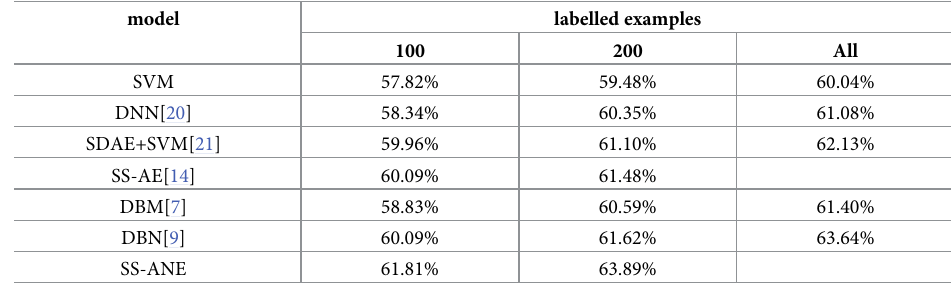
Table 4. Average accuracy rate on the Killer test set with 100,200 labelled